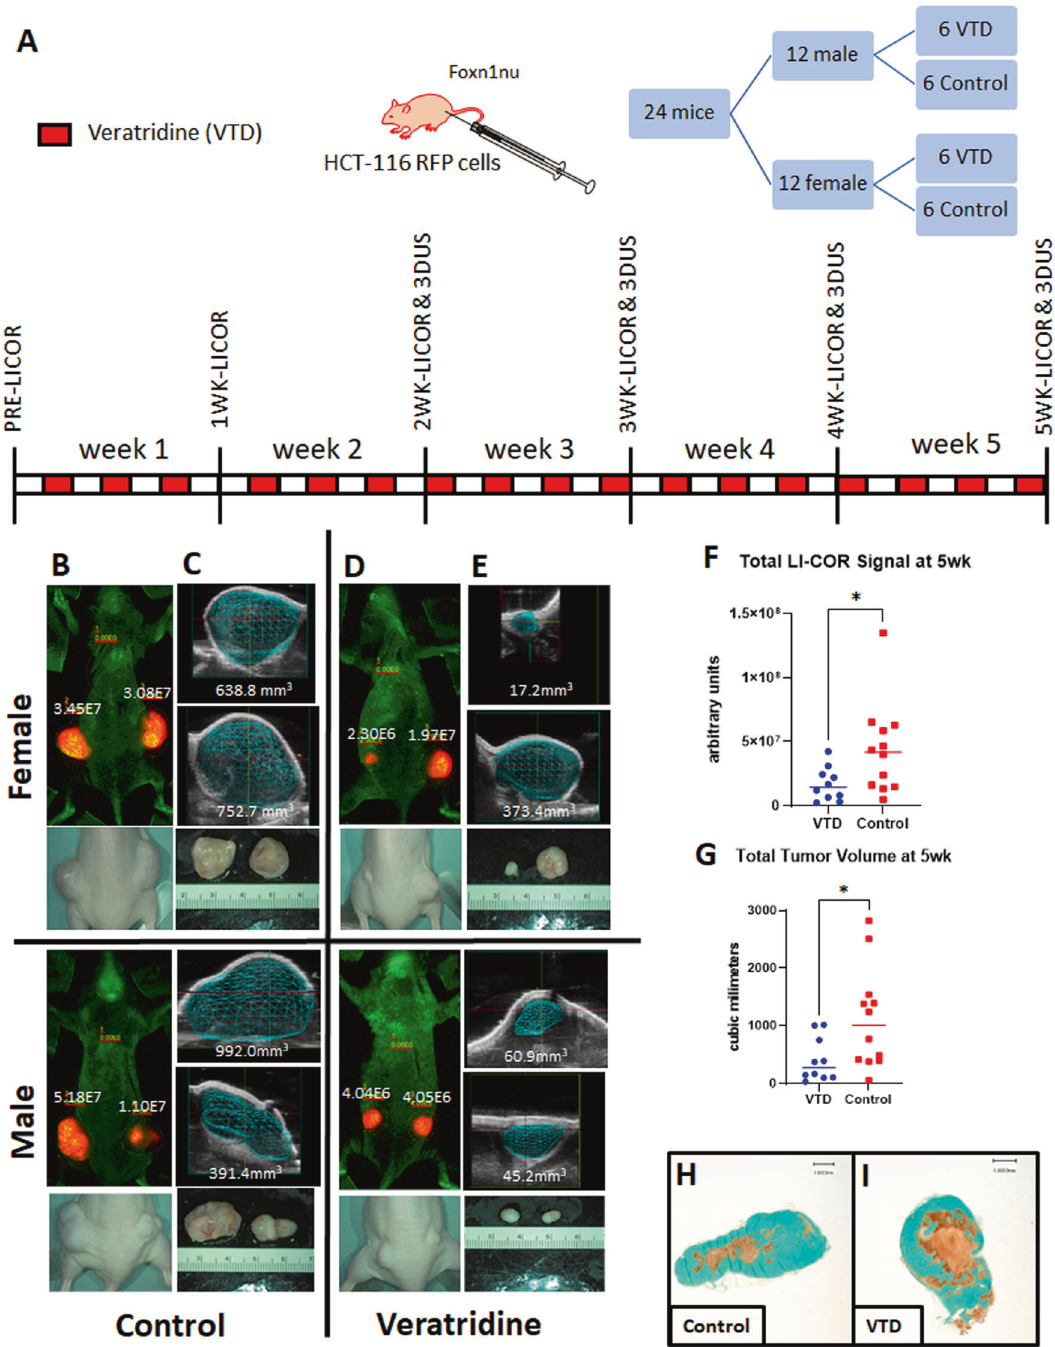
Fig. 7 VTD signi fi cantly slows tumor growth in a xenograft mouse model of colon cancer. A Mice were inoculated subcutaneously into both fl anks with 1 × 10 6 iRFP-HCT-116 cells and treated with VTD 0.1 mg/kg QOD or control using the depicted timeline. B , E iRFP signals and volume of developed xenograft tumors measured by LI-COR (Panels B , D ) and 3D ultrasound (Panels C , E ) at the 5-week endpoint. F , G VTD signi fi cantly decreased the iRFP signal in xenograft tumors measured by LI-COR technology ( F ). Tumor size was signi fi cantly decreased in VTD treated mice after 5 weeks as measured by 3D ultrasound ( G ) ( N = 10 – 12/grp, * P < 0.05). H , I Representative tumor tissue stained by TUNEL assay suggests that VTD-treated xenograft tumors had more apoptotic and necrotic were utilized; however, when possible and appropriate, animal data from 22:00 h), and provided free access to water and standard rodent chow. All cohorts were combined to reduce animal numbers needed. Animal experimental procedures were approved by the Institutional Animal Care numbers utilized for each set of experiments are included with their associated fi gure legends. All mice used in this study were maintained in the Animal Resource Center at the University of South Dakota, housed with 3 – 4 animals per cage, kept at 22 °C on a standard light cycle (lights on from 10:00 to